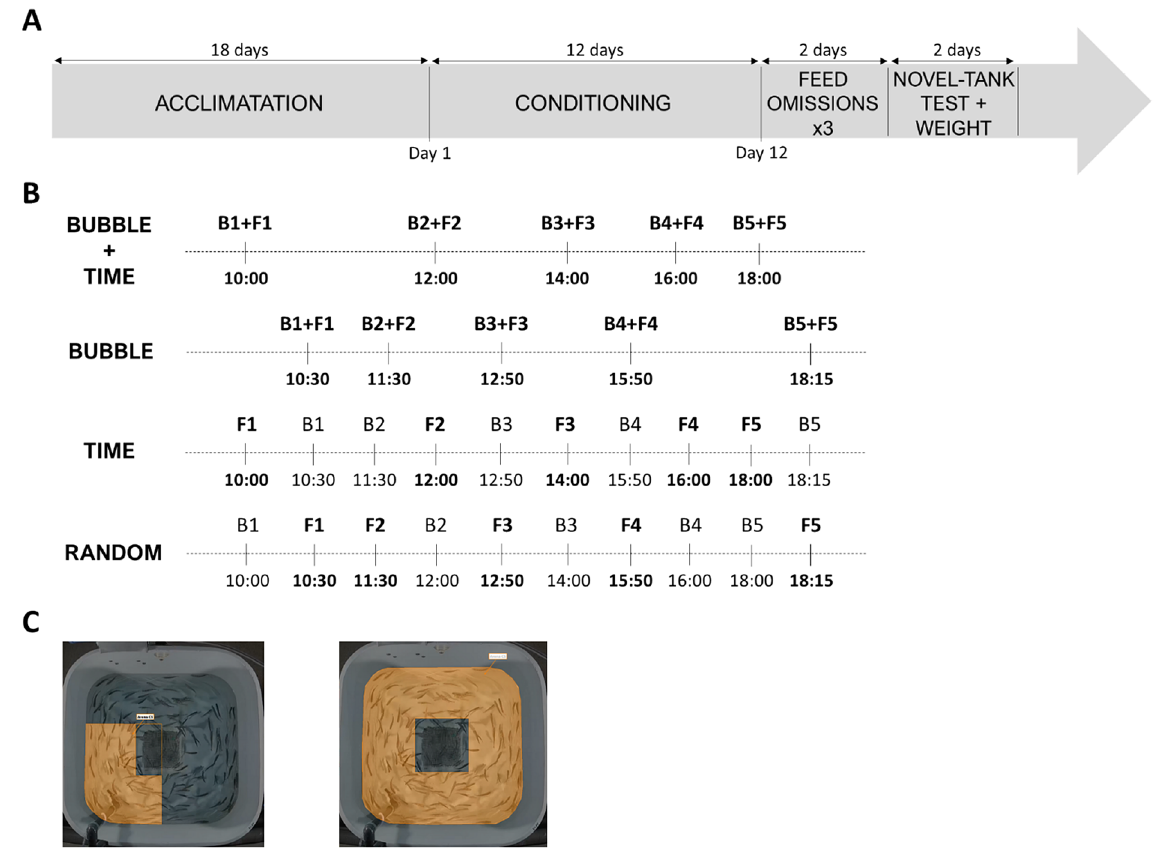
Figure 7. ( A ) General schedule of the experiment with a first period of acclimatation to the environment, the conditioning involving the four different predictability conditions of feeding between day 1 and day 12, then the three feed omissions performed in all treatments, and the novel tank-test after which growth parameters were recorded; ( B ) Example of a day during conditioning for each treatment, with BUBBLE + TIME based on temporal + signalled predictability of feeding (based on time and bubble diffusion), BUBBLE based on signalled predictability alone (based on bubble diffusion), TIME based on temporal predictability alone (based on time of day), and RANDOM corresponding to unpredictable feedings (random feeding delivery). B1 to B5 represent the five daily bubble diffusions, and F1 to F5 the five daily feedings; ( C ) Areas used for fish behaviour analyses (on the left: the bubble area where bubbles were diffused; on the right: the whole